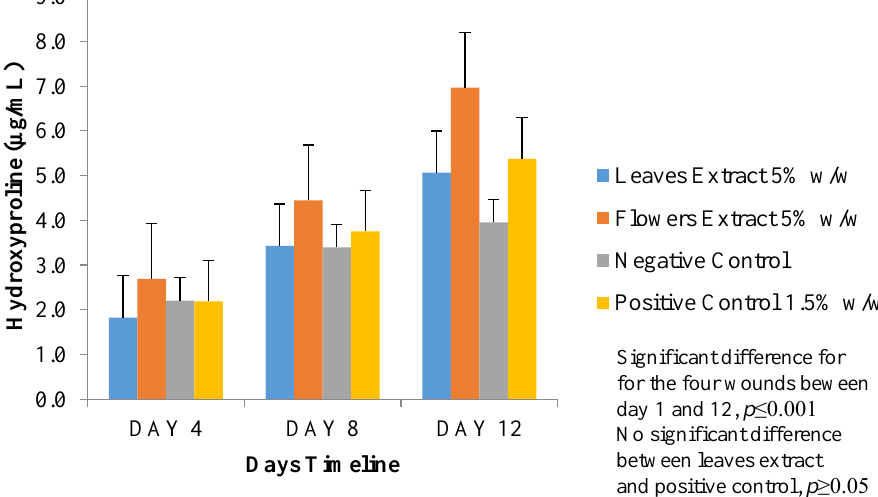
Figure 9. Hydroxyproline content (µg/mL) at day 4, 8, and 12.